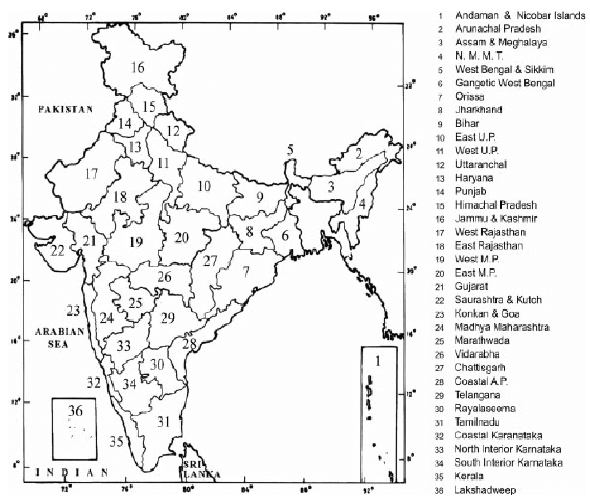
Figure 1: Meteorological sub-division map of India